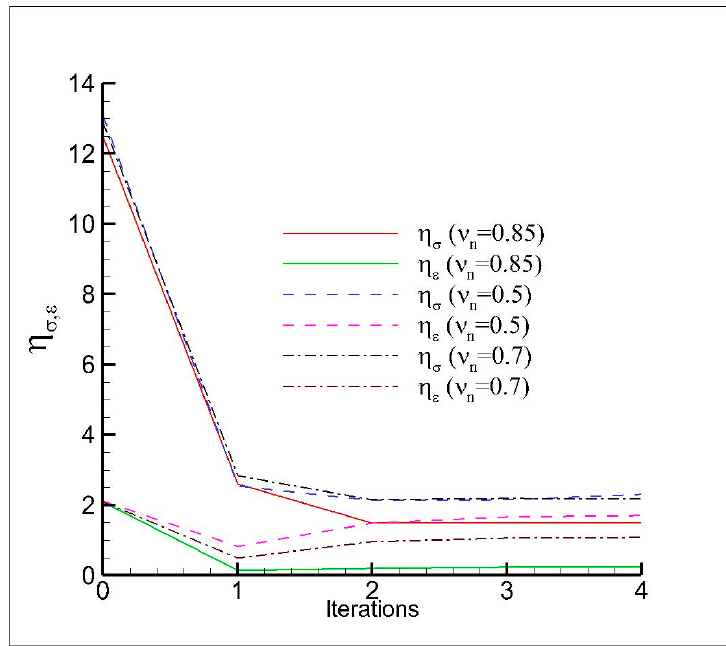
Figure 16. Global / Local performance with respect to the reference Model—comparison between Figure 16. Global/Local performance with respect to the reference Model—comparison between di ff erent levels of non–conformal meshes—Local Model 3. different levels of non–conformal meshes—Local Model 3.